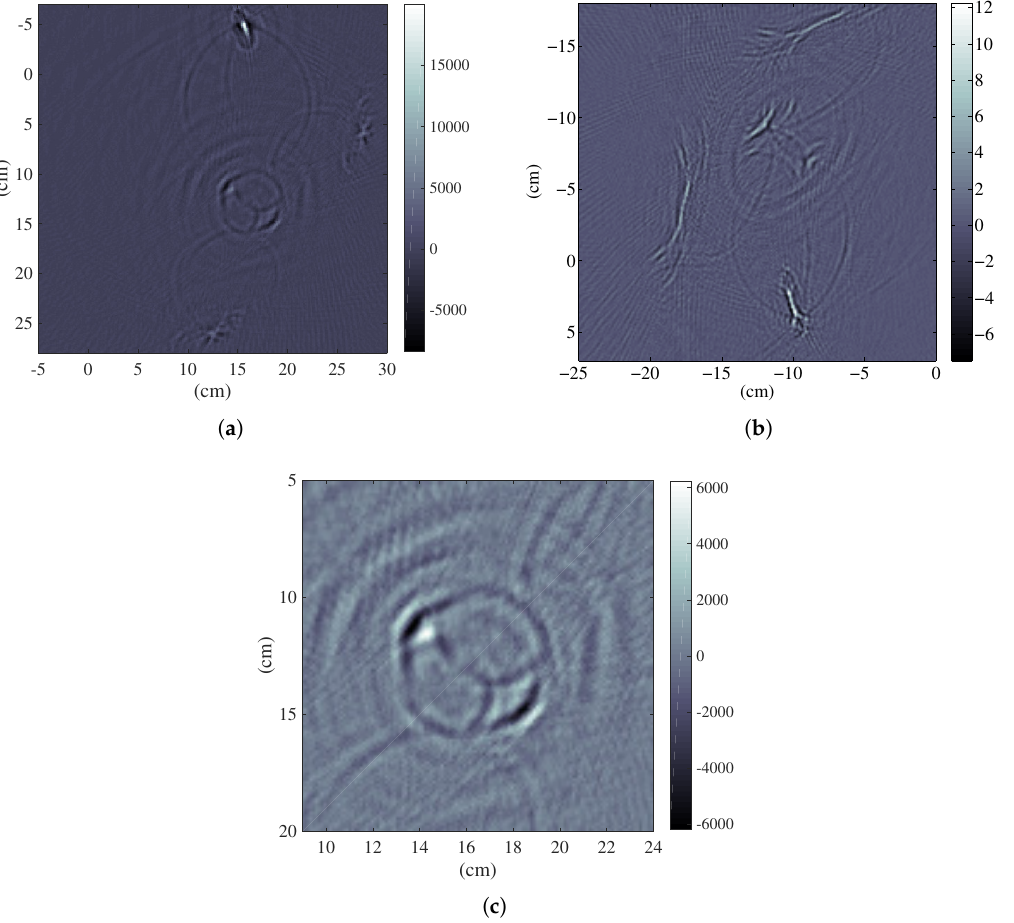
Figure 9. Reconstructed radar images and pictures of the targets. ( a ) The near–field radar image of the cylindrical pencil vase, which had a diameter of 80 mm; ( b ) The radar image of the cylindrical pencil vase with three metal cylinders in the far range; ( c ) The enlarged near-field radar image near the cylindrical pencil